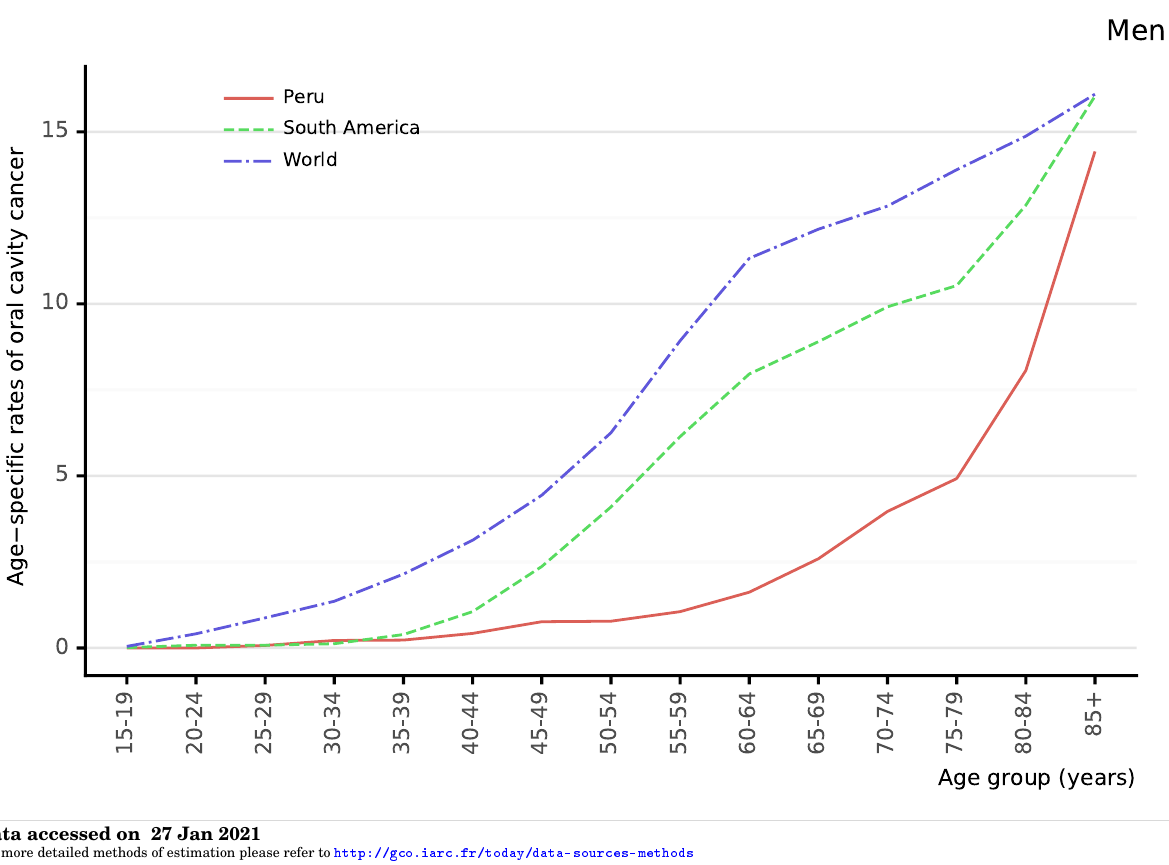
Figure 130: Comparison of age-specific oral cavity cancer mortality rates among men by age in Peru, within the region, and the rest of